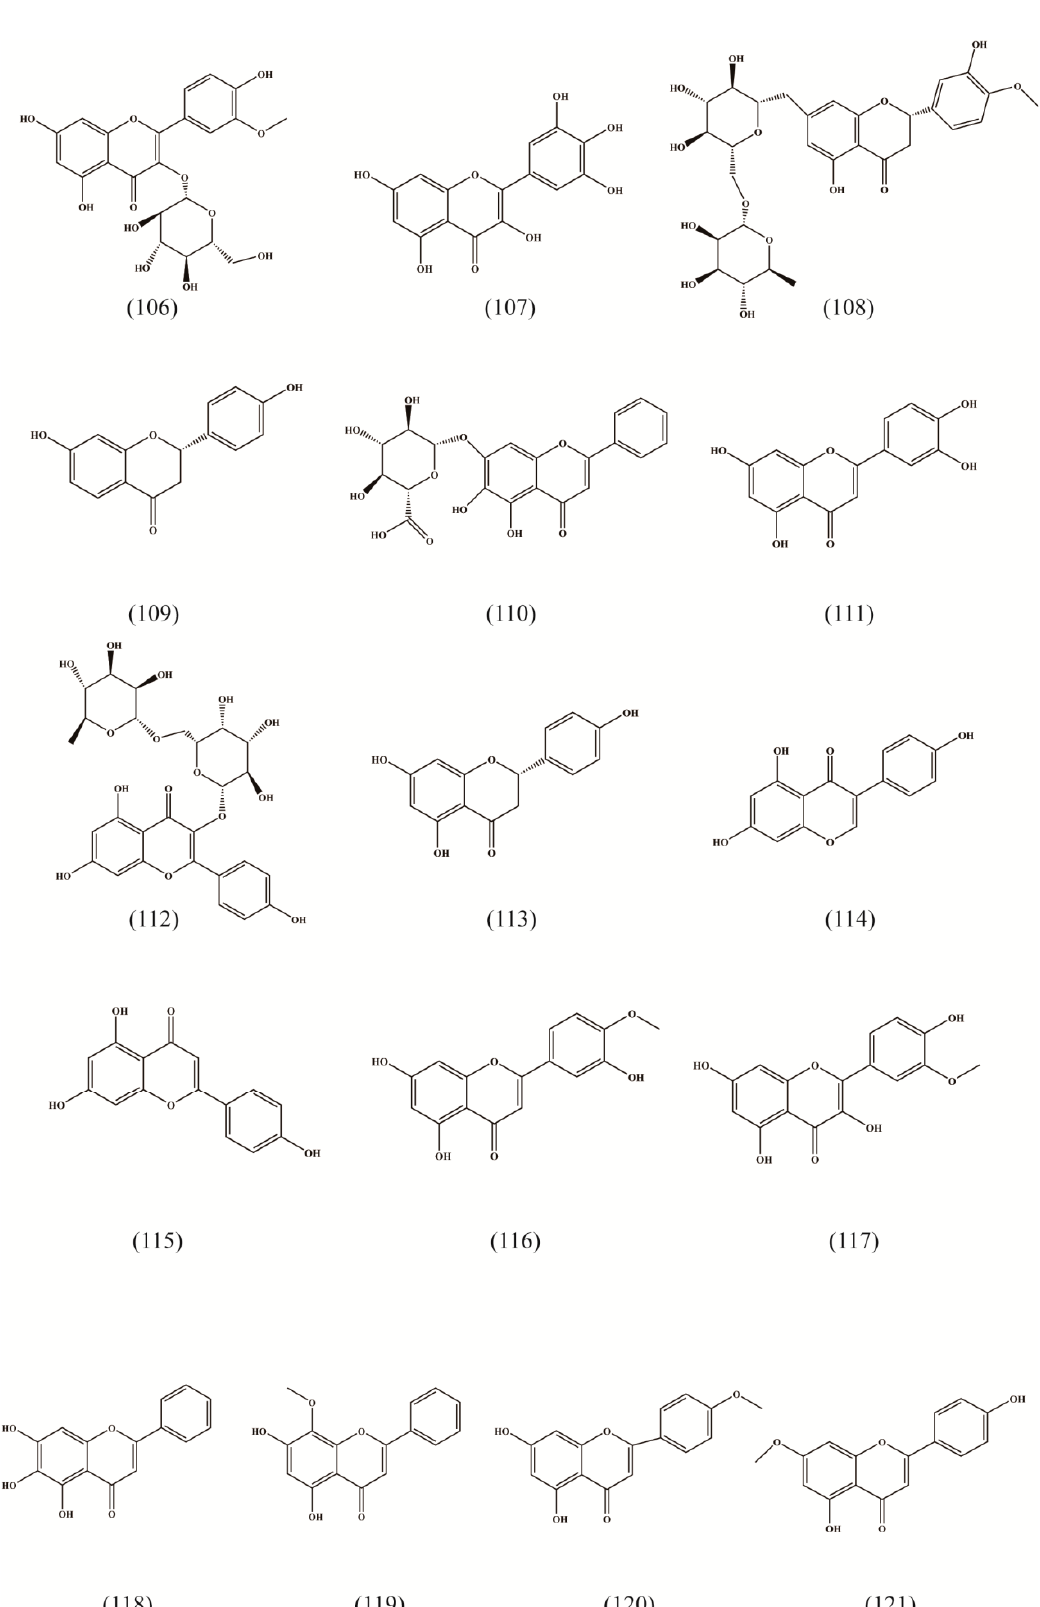
Figure 5. Structures of flavonoids isolated from Radix Asteris.